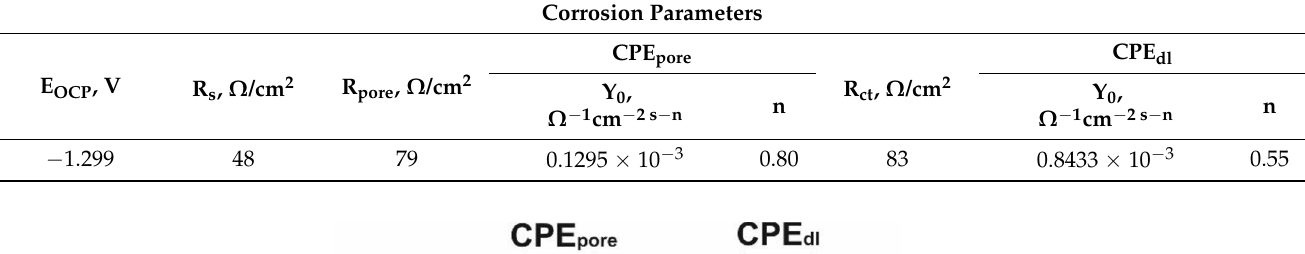
Figure 13. Impedance spectra obtained for Mg–Zn–Ca–Au sintered alloy. ( a ) Nyquist diagram, ( b ) Bode’s diagram. The symbols in ( b ) refer to the amplitude (circles) and phase spectra (“plus” sign). Table 6. Corrosion parameter values: E OCP , R s , R pore , CPE pore , R ct , CPE dl for sintered Mg–Zn–Ca– Au alloy. Corrosion Parameters